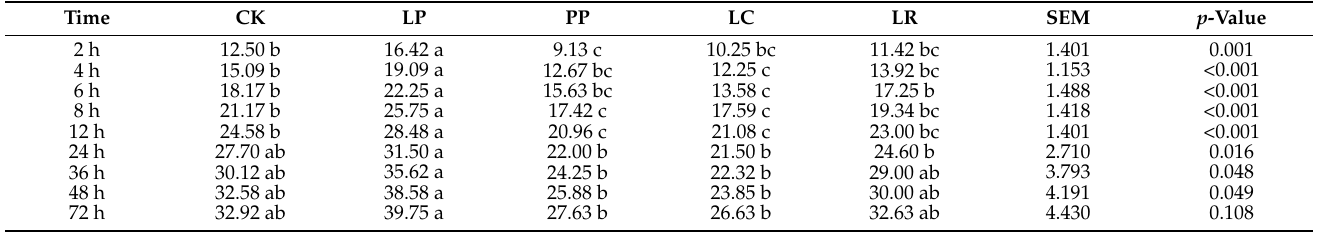
Table 5. Cumulative gas production (mL/200 mg DM) of the oat silage within 72 h of in vitro fermentation.